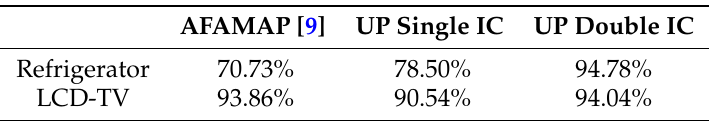
Table 7. Precision percentages comparison between Kolter and Jaakkola [9]’s AFAMAP algorithm and the User Presence Single and Double Interval Conditioning.